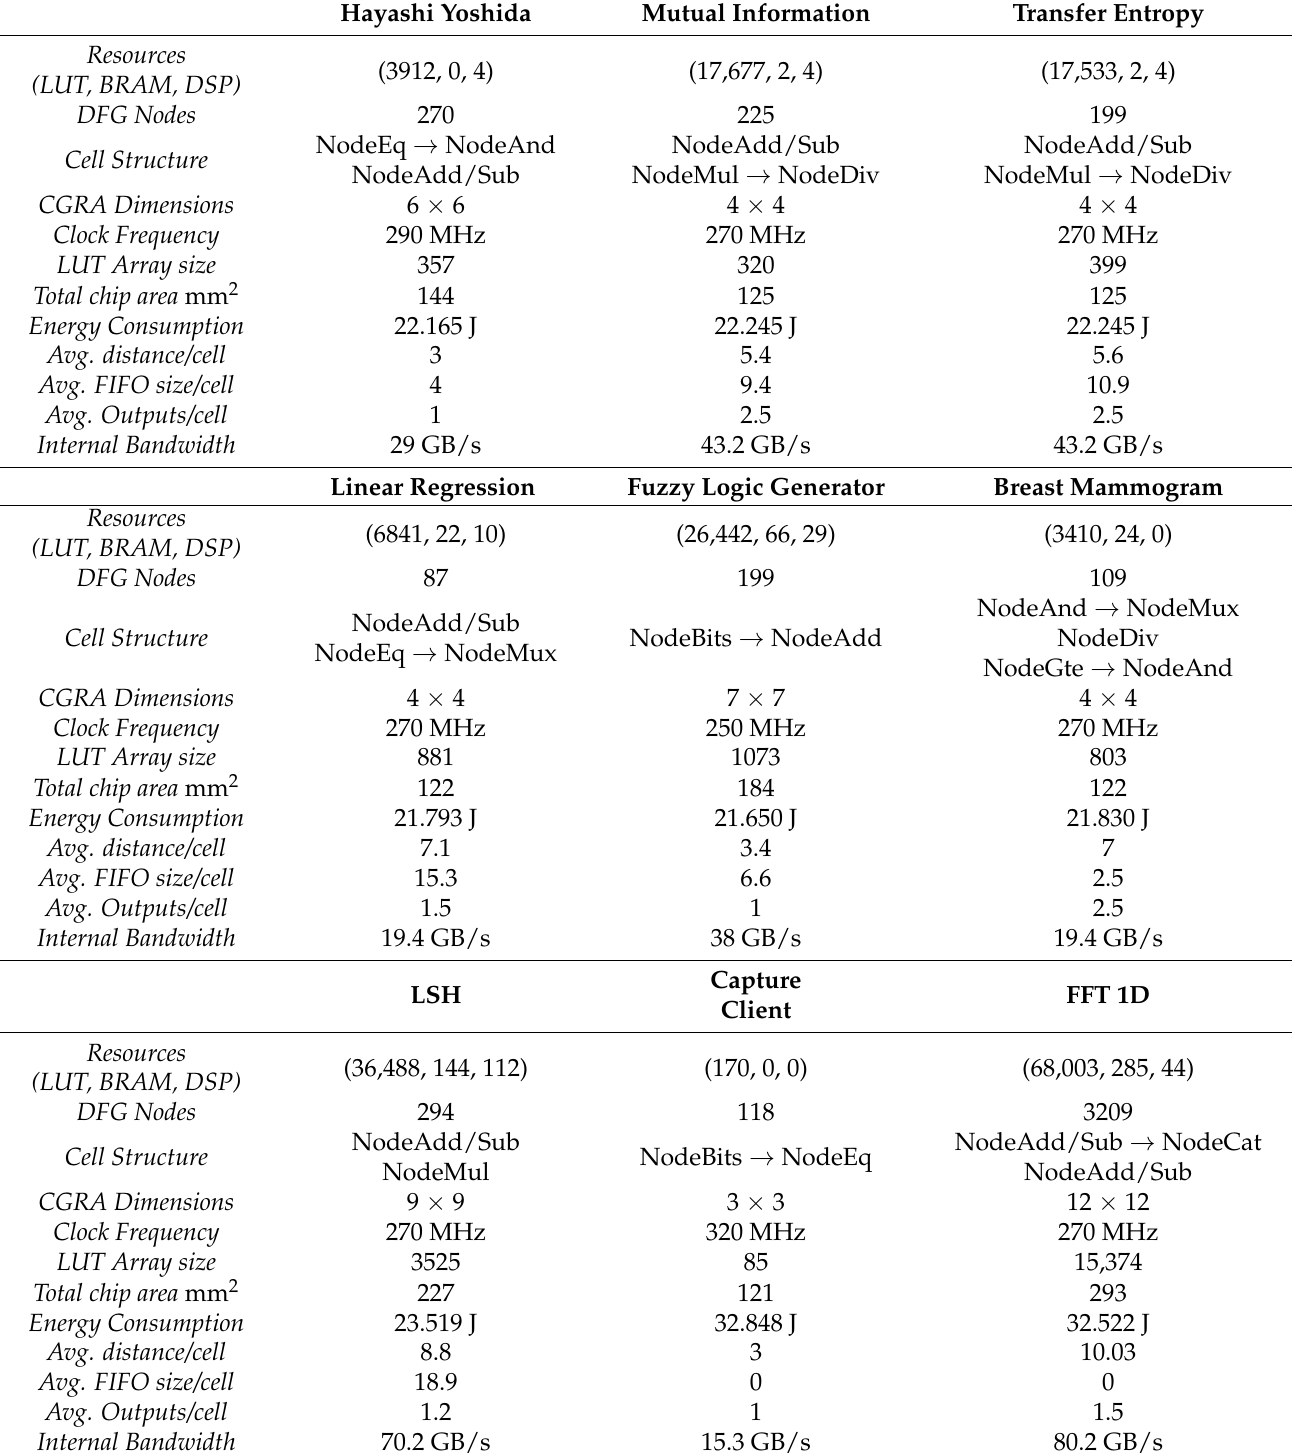
Table 6. MC-DeF experimental